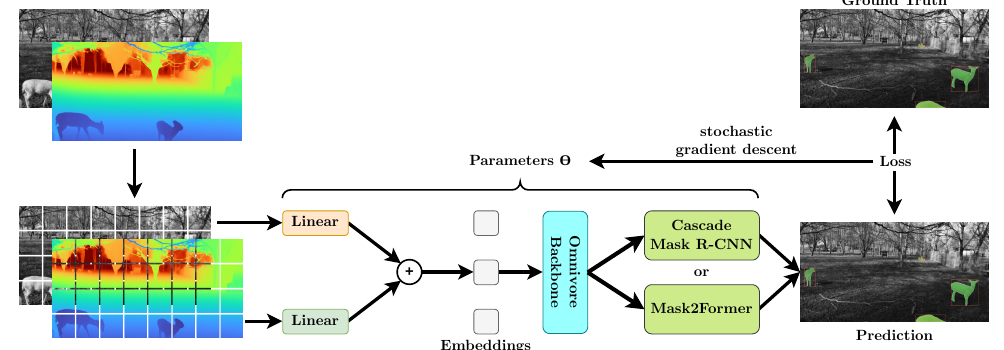
Figure 5. The data flow of our RGB-D instance segmentation model using Omnivore [19] and Cascade Mask R-CNN [42] or Mask2Former [15]. In Omnivore, the grayscale and depth images are first split into 2D patches, linearly embedded and added together. The resulting embeddings are then passed through the Omnivore backbone, which generates hierarchical feature maps. These feature maps are then used by Cascade Mask R-CNN or Mask2Former to perform instance segmentation. The entire model is optimized via stochastic gradient descent via the AdamW optimizer [47]. The model architectures and loss computation are described in detail in